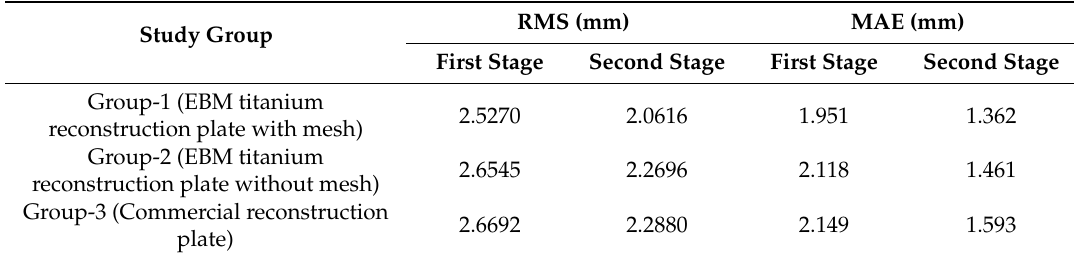
Table 2. 3D comparison results data of the study animals from di ff erent groups. RMS (mm) MAE (mm) Study Group First Stage Second Stage First Stage Second